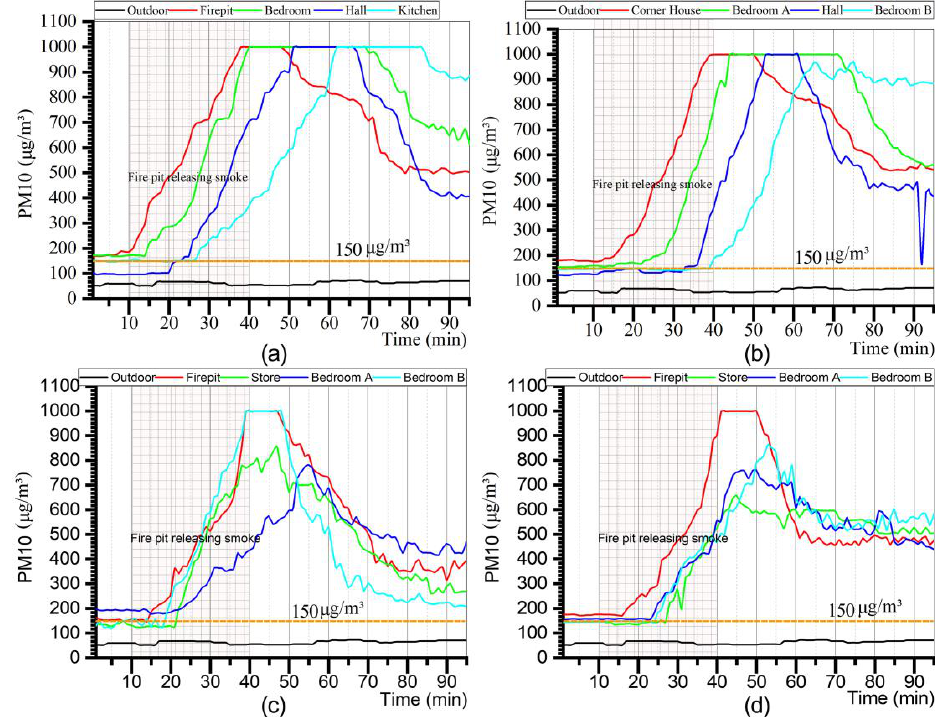
Figure A3. Indoor PM 10 concentration monitoring results. ( a ) Zuozi dwelling [34], ( b ) L-shape dwelling [34], ( c ) lower store and upper house dwelling, ( d ) front store and back house